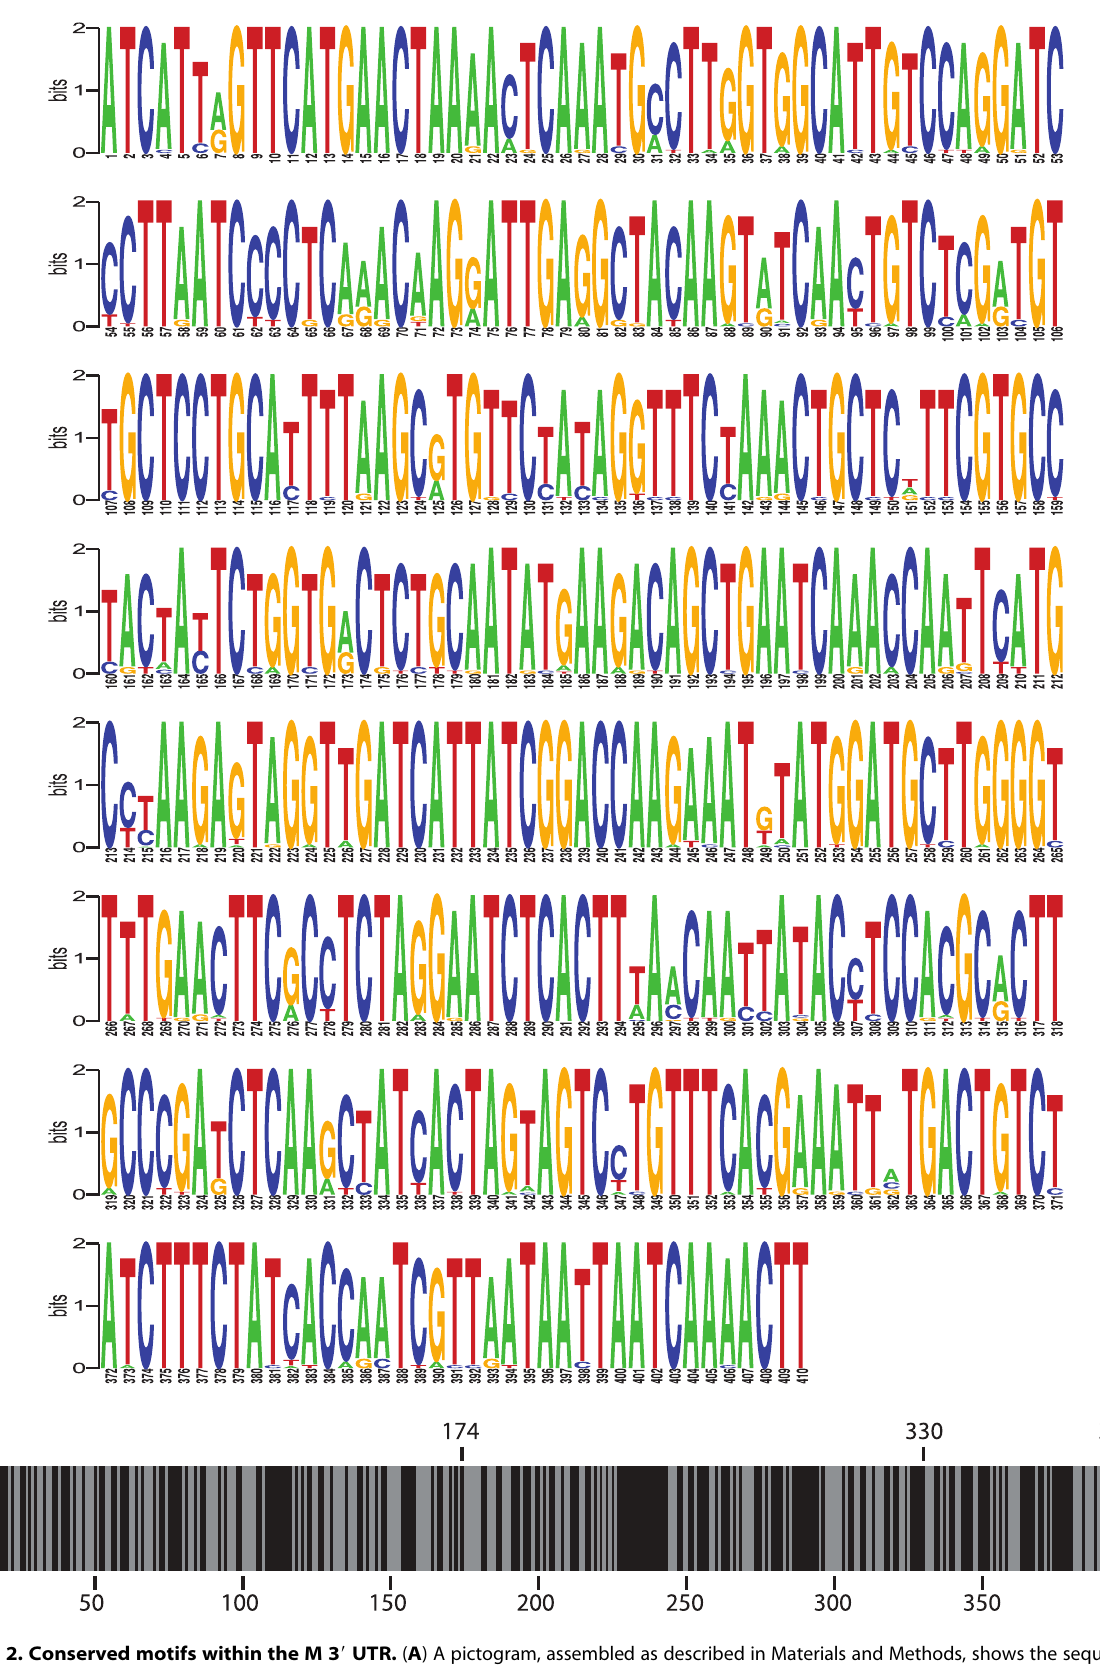
Figure 2. Conserved motifs within the M 3 9 UTR. ( A ) A pictogram, assembled as described in Materials and Methods, shows the sequence and frequency of the 410 nucleotides of the M 3 9 UTR. A base height of 2 bits indicates 100% conservation of that nucleotide across the 26 CDV sequences. The numbering below the pictogram indicates the position in the UTR, with 1 being first nucleotide following the M stop codon and PLoS ONE |